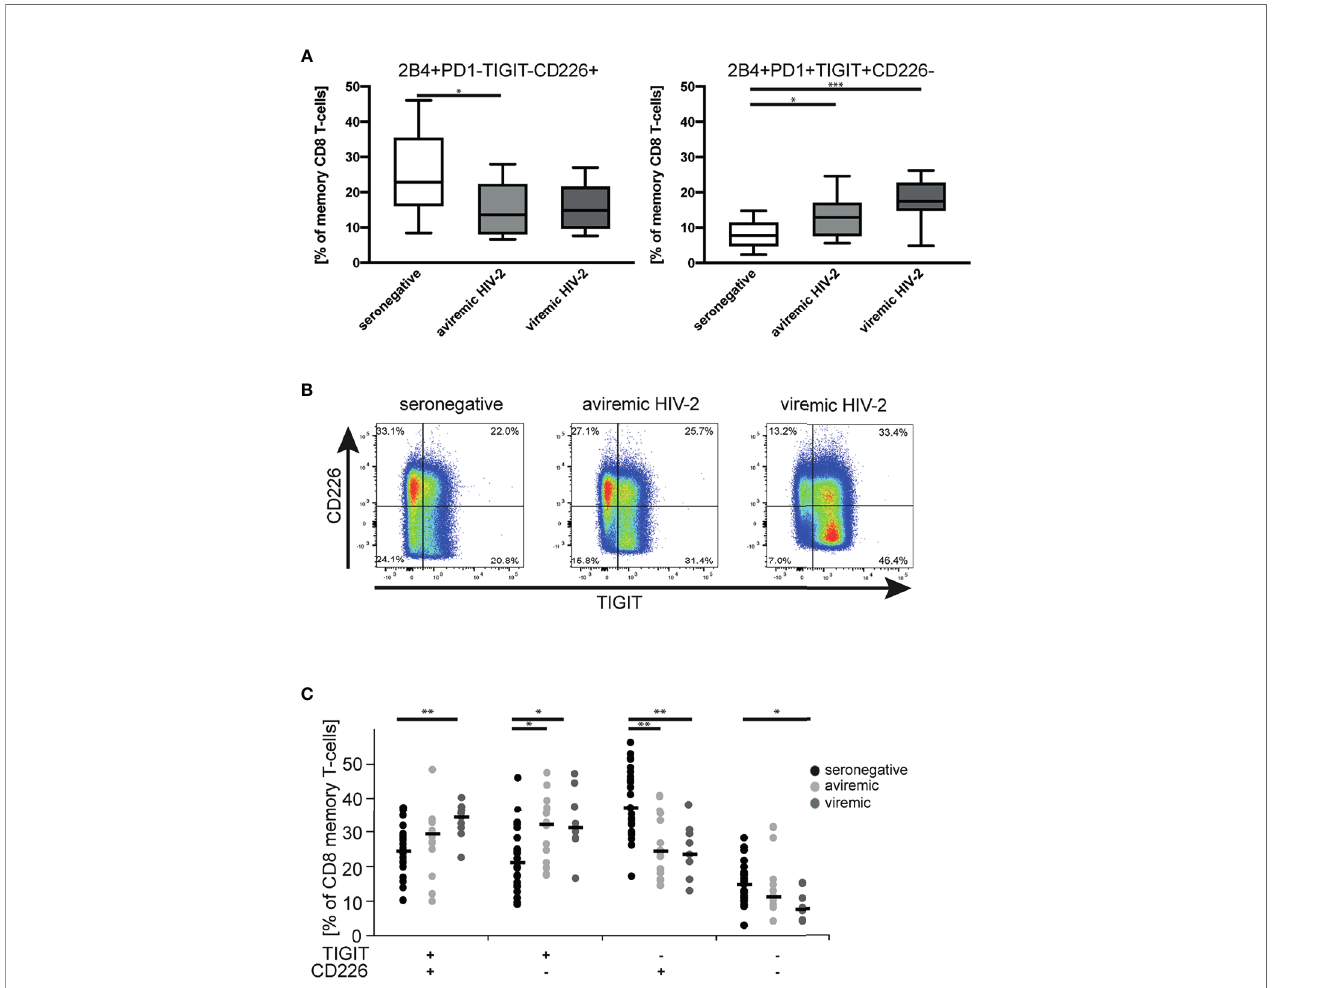
FIGURE 4 | Frequencies of memory CD8 T-cells co-expressing different patterns of stimulatory and inhibitory checkpoint markers. Tukey box plots illustrating frequencies of speci fi c memory CD8 T-cell populations being (A) 2B4+PD-1-TIGIT-CD226+ or 2B4+PD-1+TIGIT+CD226- in seronegative participants (n = 27) and treatment naïve aviremic (n = 14) and viremic (n = 9) HIV-2-infected individuals. (B) Examples of fl ow cytometry plots depicting the expression of CD226 and TIGIT on memory CD8 T-cells of representative study participants. (C) Expression patterns of TIGIT and CD226 on memory CD8 T-cells in the study participants depicted above. The black bars depict medians. Statistical differences between groups were analyzed using Kruskal-Wallis test and Dunn´s post-test. *p < 0.05, **p < 0.01 and ***p <